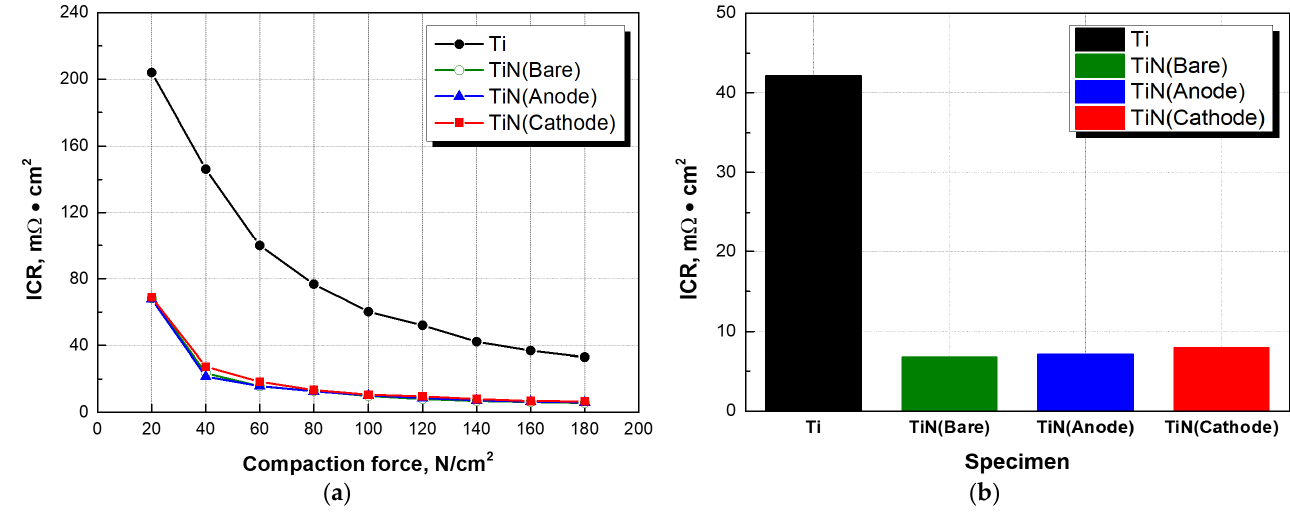
Figure 8. Interfacial contact resistance of titanium substrate and TiN-coated specimen. ( a ) at various compressive force; ( b ) at 140 N/cm 2 . Table 6. Interfacial contact resistance measured at various compressive stress.